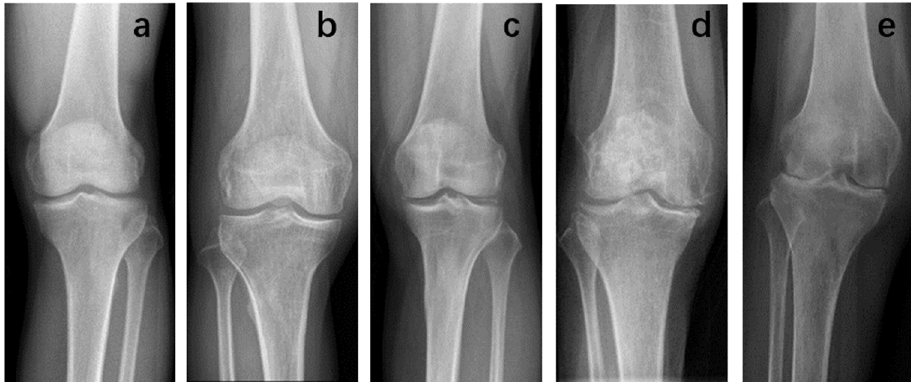
Figure 2. K-L classification. The patient was graded on an X-ray of the knee joint according to the method previously described. ( a ) Grade 0; ( b ) Grade I; ( c ) Grade II; ( d ) Grade III; ( e ) Grade IV.